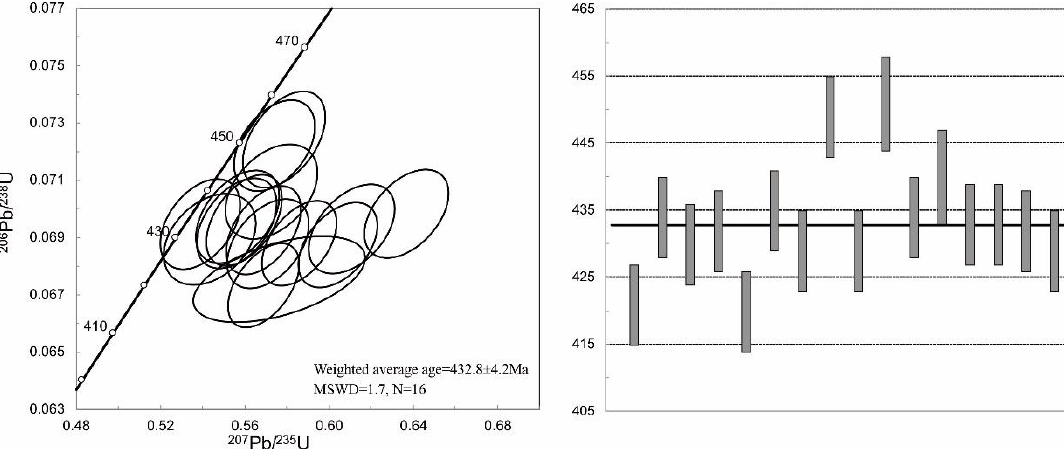
Figure 10. Zircon U-Pb Concordia ages diagram of the host magma (monzogranite) in the Qingshanbao